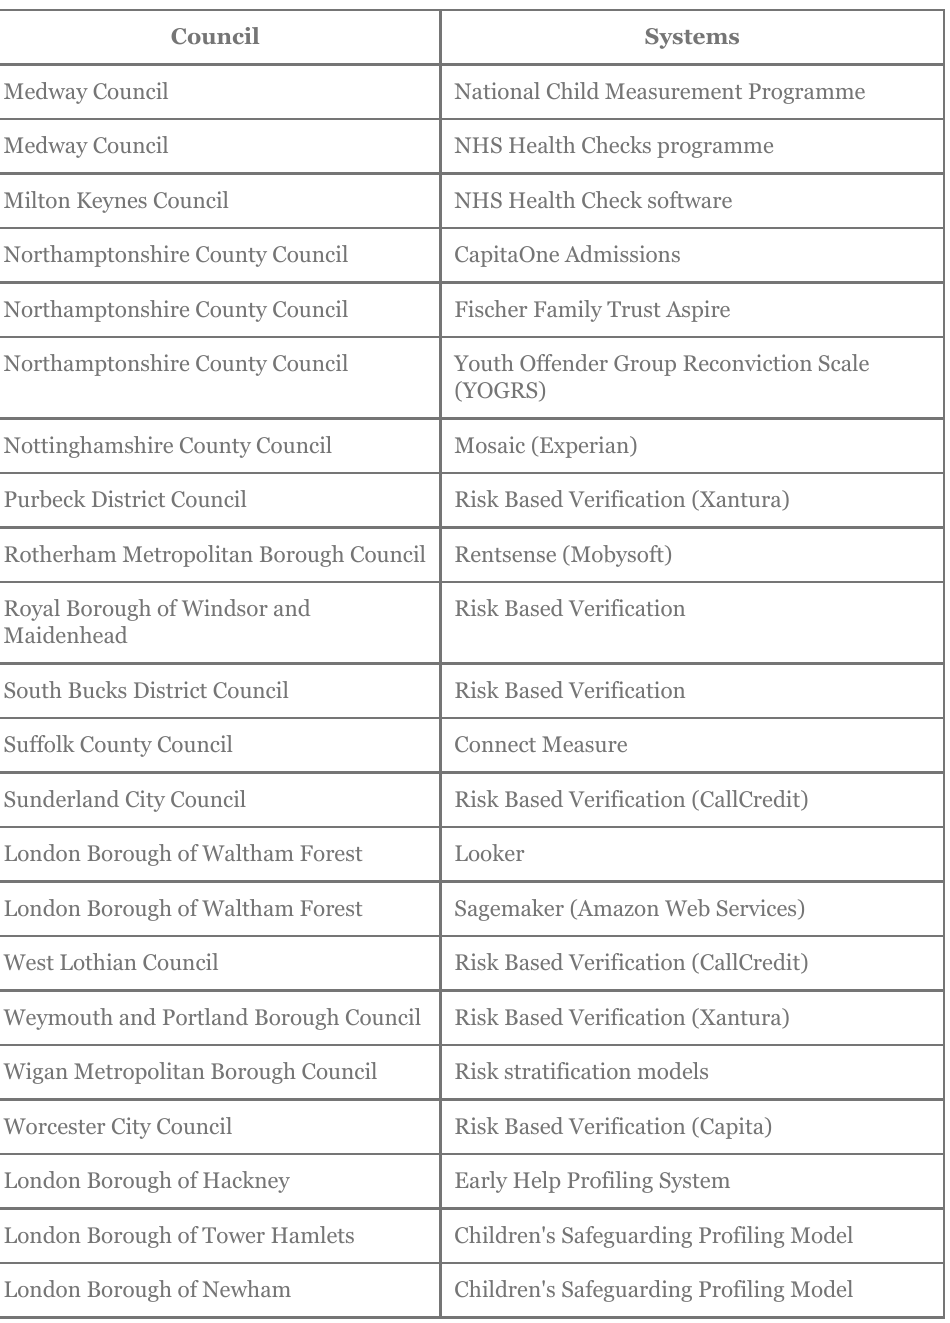
Table 3: Use of predictive policing programmes in the UK (source: Liberty, 2019) Police